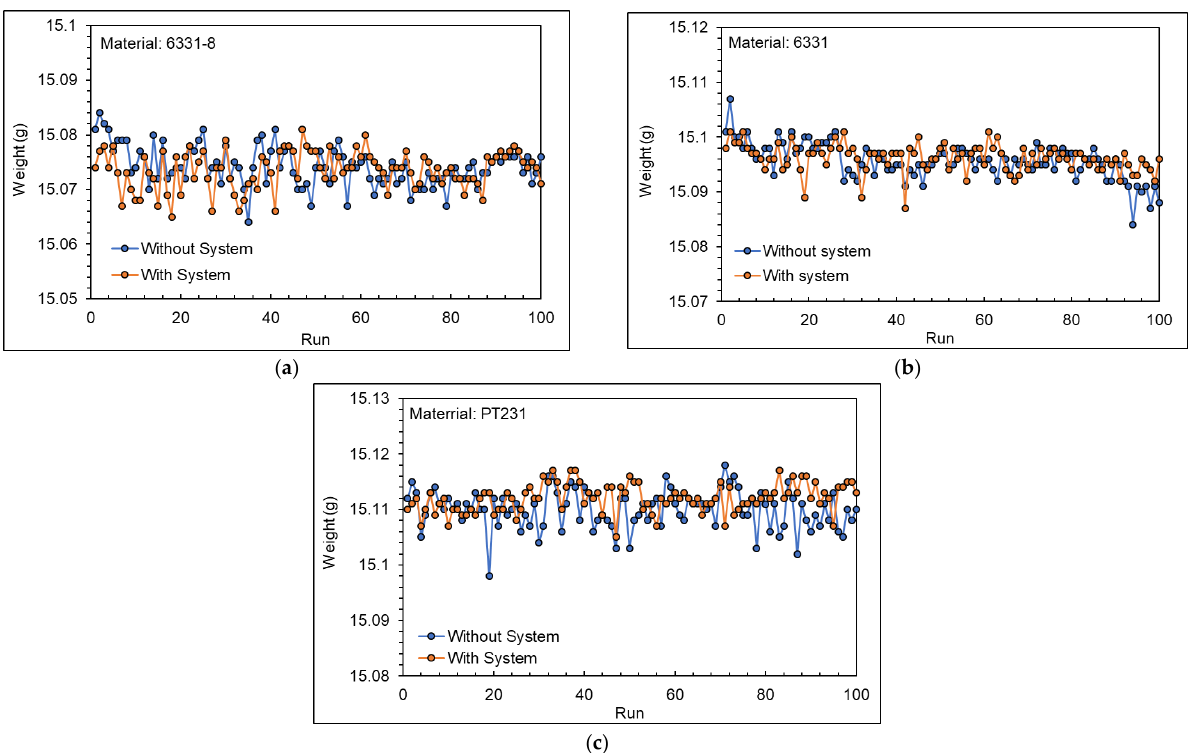
Figure 25. Product weight with and without the adaptive process control system experiments (( a ) 6331 − 8, ( b ) 6331, and ( c ) PT231).